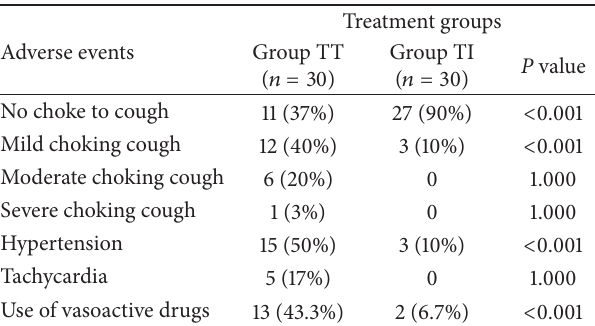
Table 3: Adverse events during the